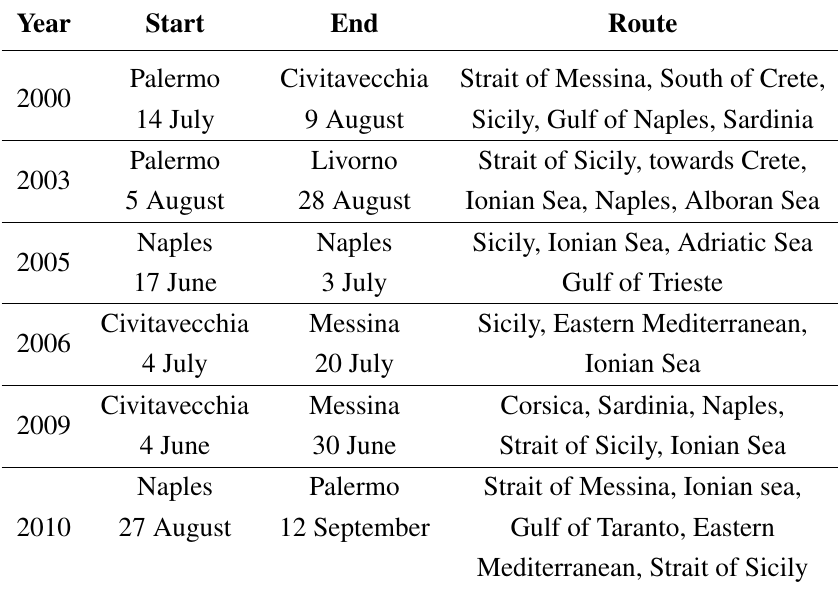
Table 1. The oceanographic campaign periods and approximate routes.